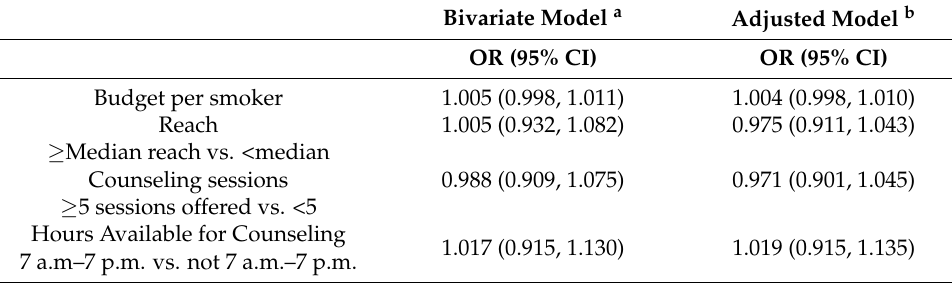
Table 2. Odds ratios for 90-day smoking cessation associated with quitline exposure